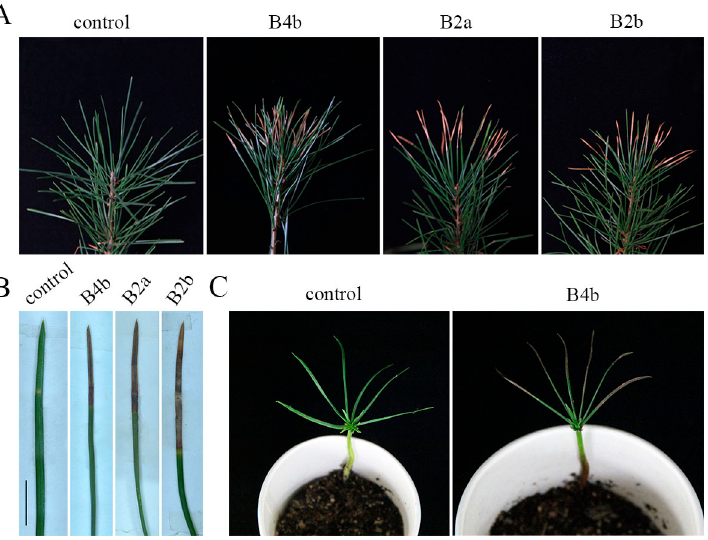
Figure 2. Pathogenicity of A. alternata on Bunge’s pine and Korean pine achieved by mycelial discs. ( A ) Pathogenicity on 2-year-old seedlings of Bunge’s pine. ( B ) Pathogenicity on detached needles of Bunge’s pine. ( C ) Pathogenicity on 2-month-old seedlings of Korean pine. Scale bars: ( B ) = 5mm.